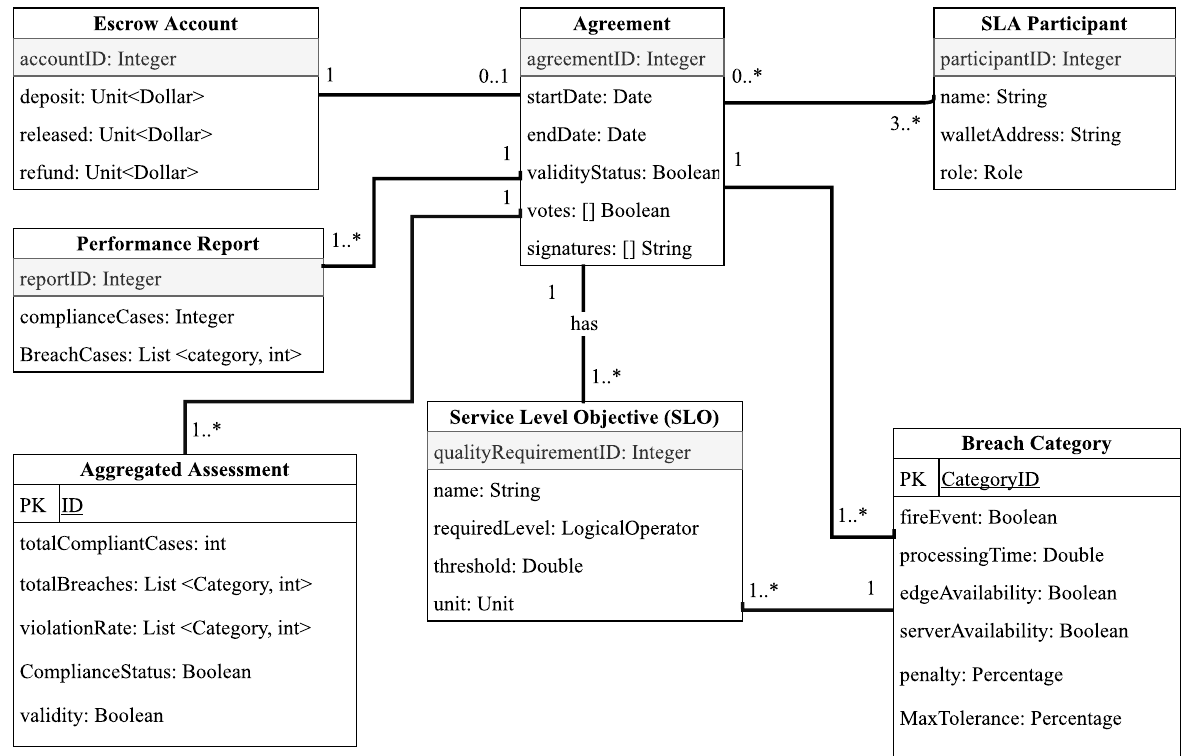
Fig. 14 Enhanced Data Model for Evaluation Compliance over